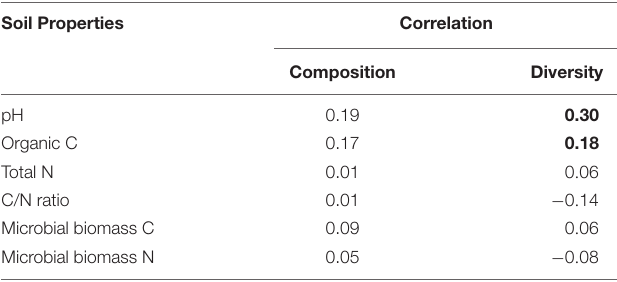
TABLE 3 | Correlations of bacterial community composition based on the distribution of OTUs and Shannon diversity index with soil properties using the RELATE in the PRIMER V6 software a